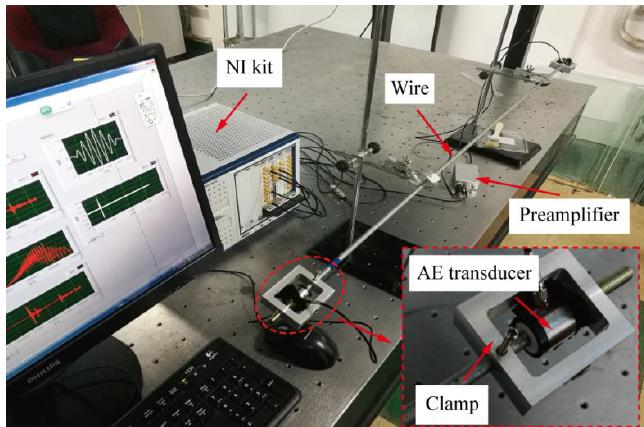
Figure 2. Experimental setup overview.